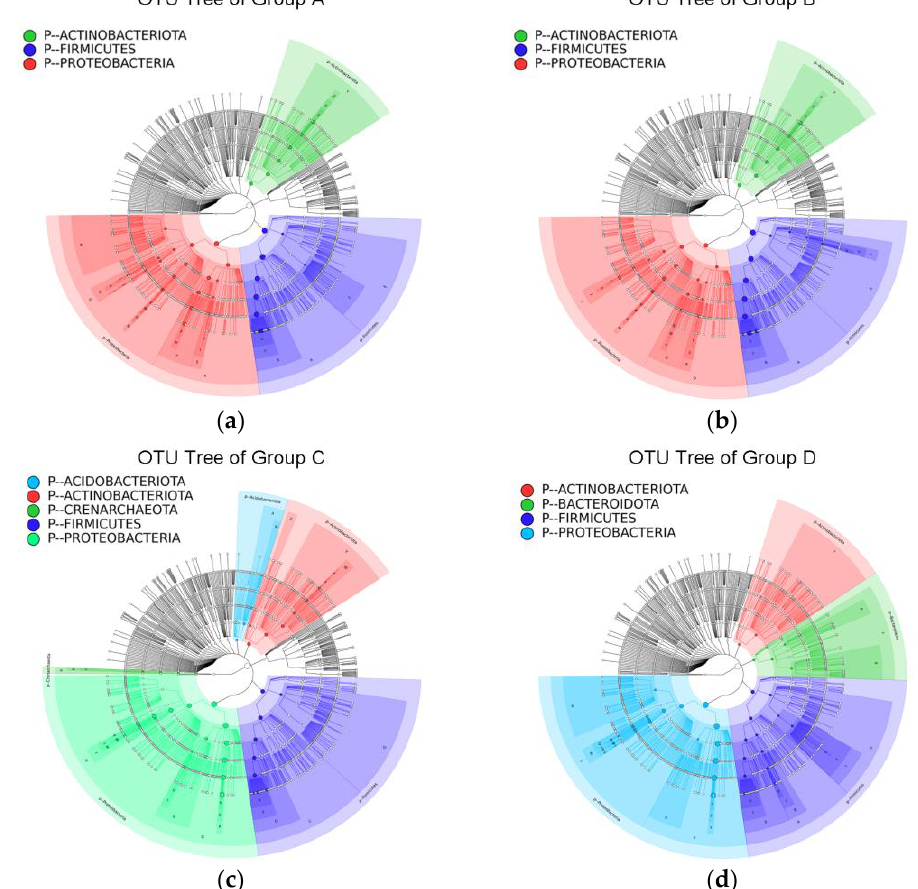
Figure 2. OTU annotation tree construct for each sample group (A: bee samples demonstrating low V. ceranae spore count; B: bee samples demonstrating high V. ceranae spore count; C: bee bread collected from colonies with low V. ceranae spore count and D: bee bread collected from colonies with high V. ceranae spore count), generated by V3 – V4 16S rRNA region, in ( a – d ), respectively. Different taxonomic ranks range from inside out. Size of circles stands for abundance of species. Different colors stand for different phyla. Solid circles stand for the top 40 species in high abundance. Full-size tree constructs are provided as supplementary material.